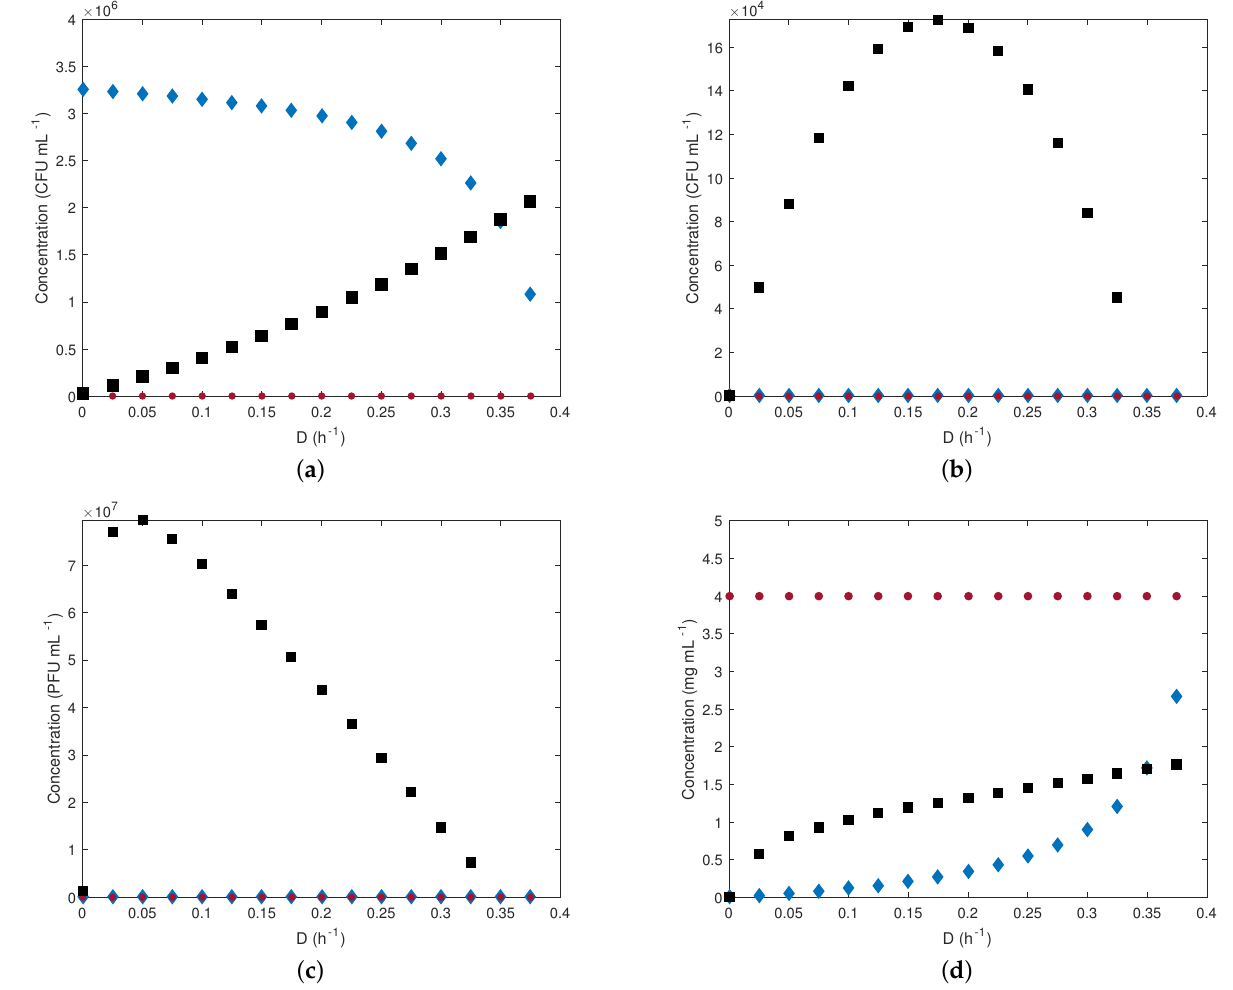
Figure 1. Equilibrium points. ( a ) Susceptible bacteria. ( b ) Infected bacteria. ( c ) Phages. ( d ) Substrate. • : trivial equilibrium point, (cid:7) : equilibrium point 2, and (cid:4) : equilibrium point